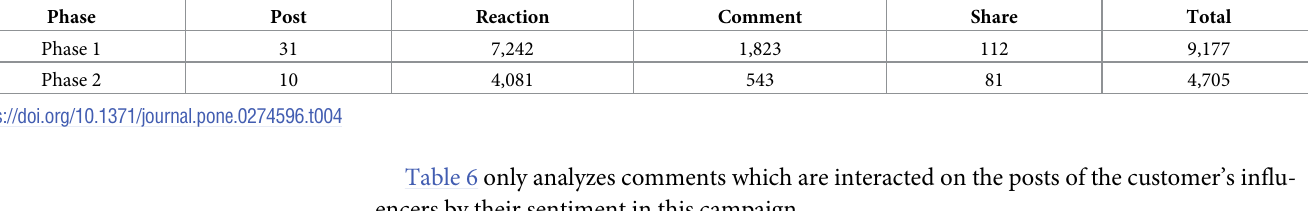
Table 6 only analyzes comments which are interacted on the posts of the customer’s influ-